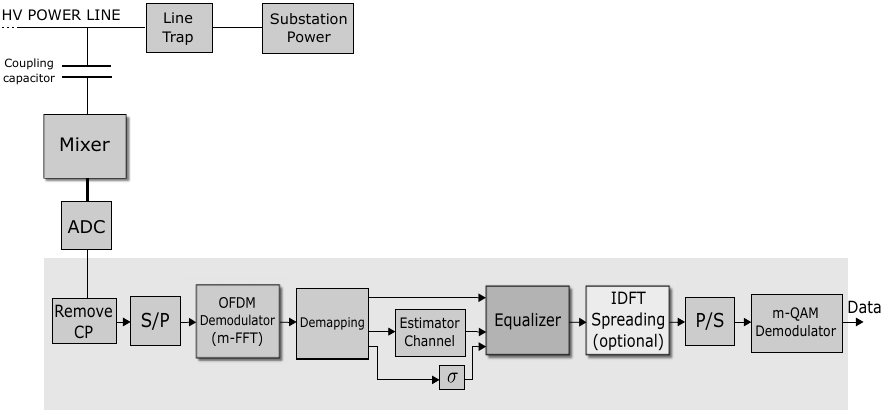
Figure 10. Models of the PLC-OFDM and PLC SC-FDM receivers in the baseband processing